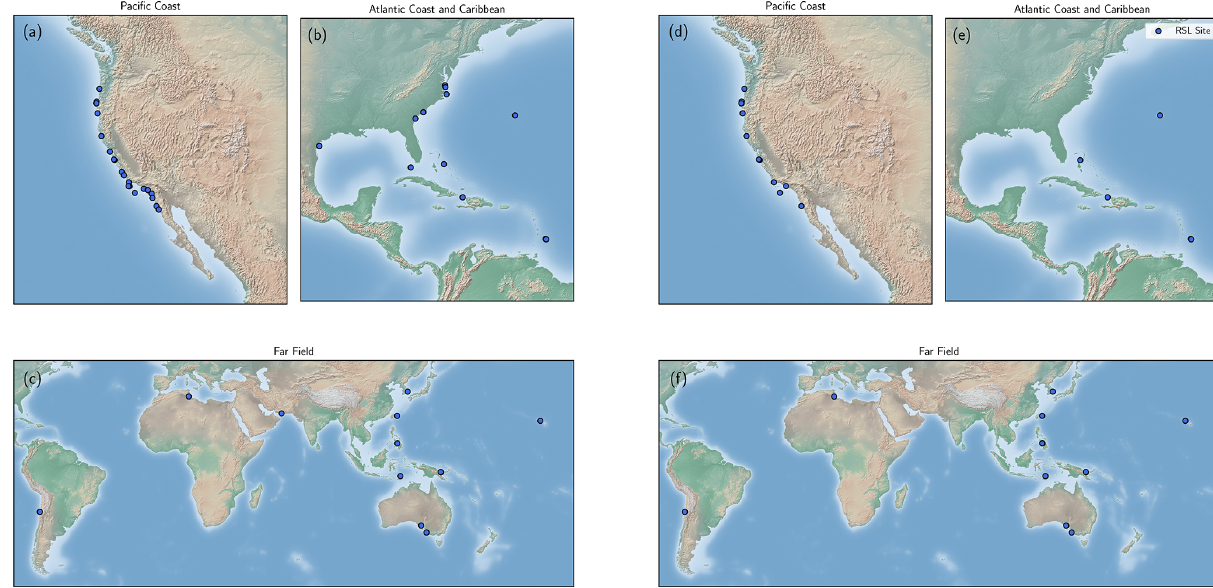
Figure 1. Locations of MIS 5a (a–c) and MIS 5c (d, e) RSL indicator sites for (a, d) the Pacific coast of North America, (b, e) Atlantic coast of North America and the Caribbean, and (c, f) the remaining globe atop the Matplotlib Basemap Shaded Relief map (Hunter,